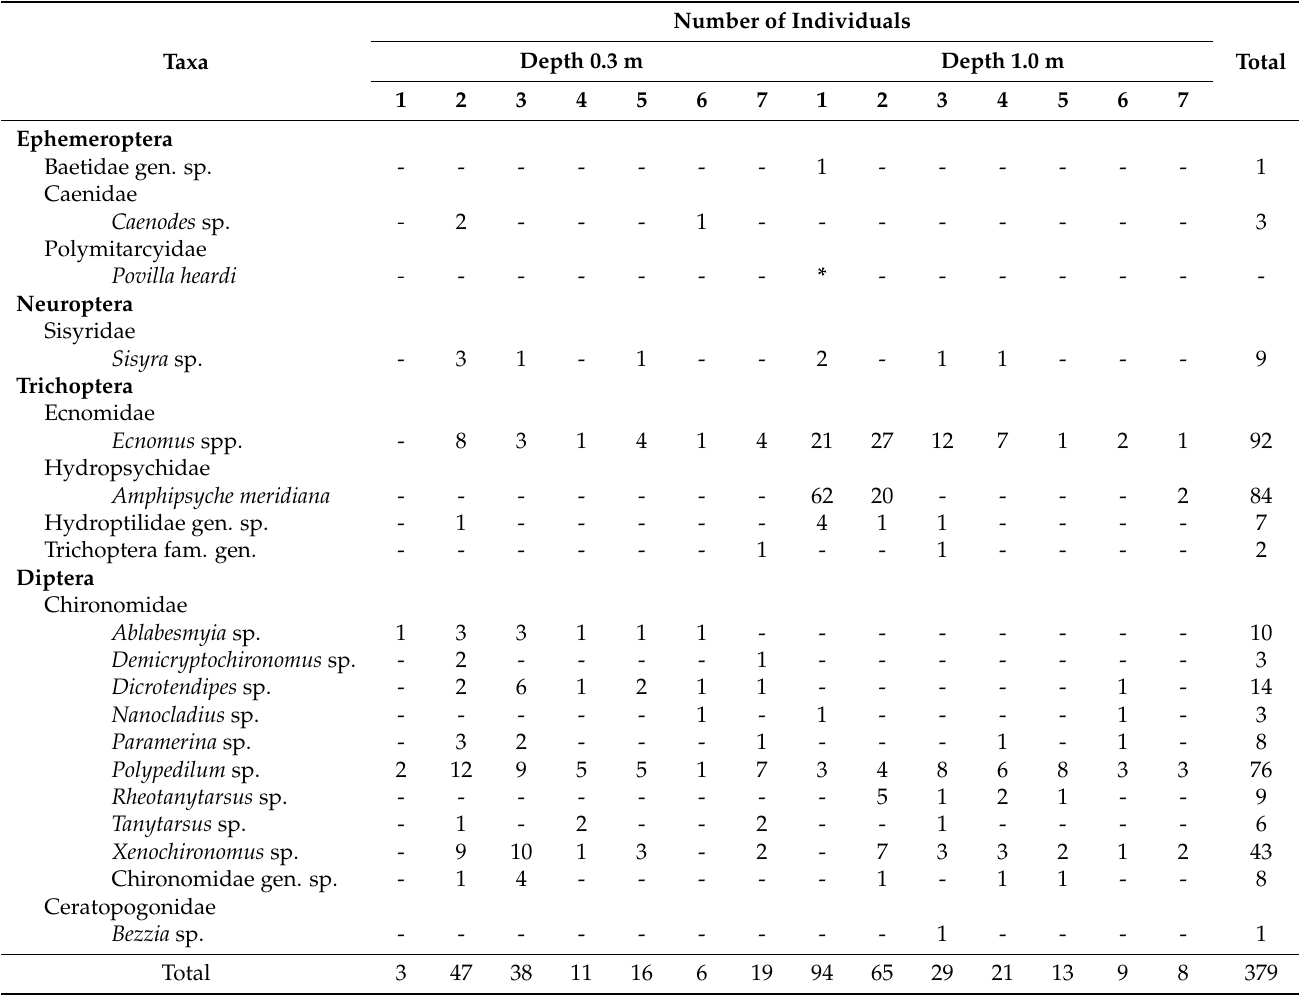
Table 1. Checklist of aquatic insects associated with Corvospongilla siamensis in the Pong River (Lower Mekong, Thailand). Total number of larvae and/or pupae in each sponge sample at two water depths. Presence of eggs is indicated by asterisk